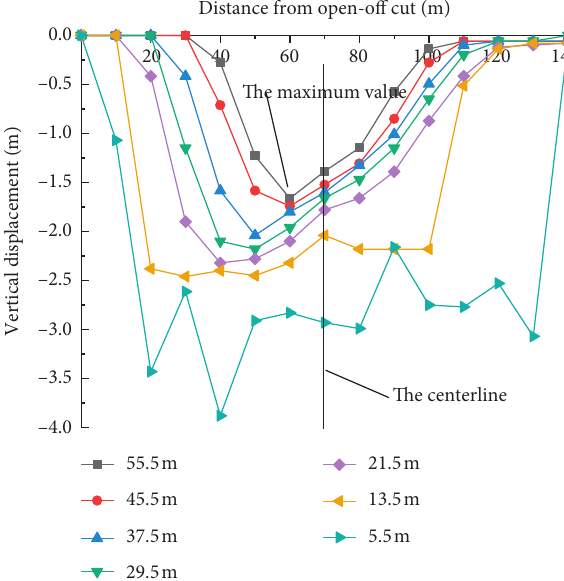
Figure 15: Vertical displacement distribution of bedrock